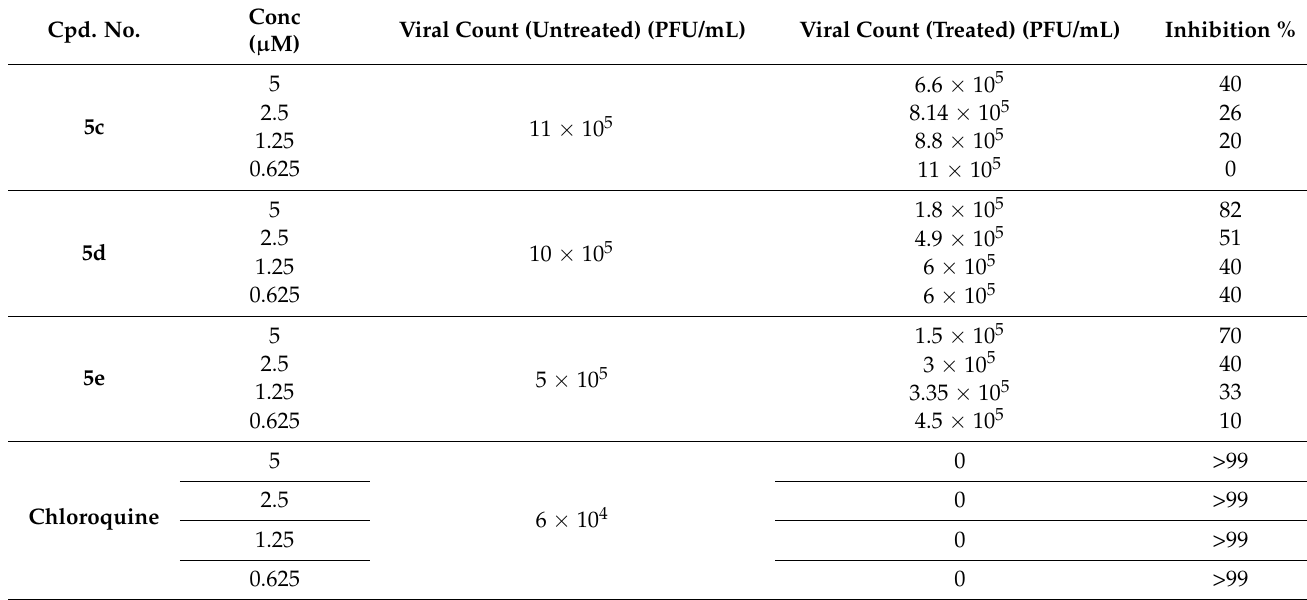
presence of the methyl group as described in 5-(pyrrolidin-1-ylsulfonyl)-2 (cid:48) ,8 (cid:48) -dithioxo- 5-(piperidin-1-ylsulfonyl)-1 (cid:48) H -spiroindoline derivatives 4b and 4e with a methyl